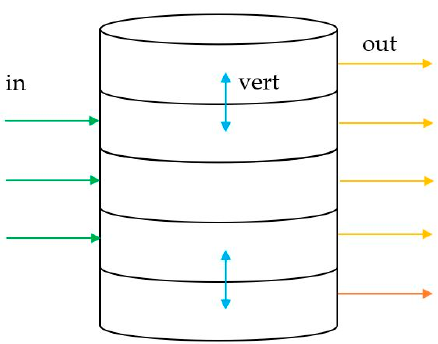
Figure 3. Schematic representation of nodal approach for stratified storage tank, showing incoming, outgoing, and vertical mass flows.